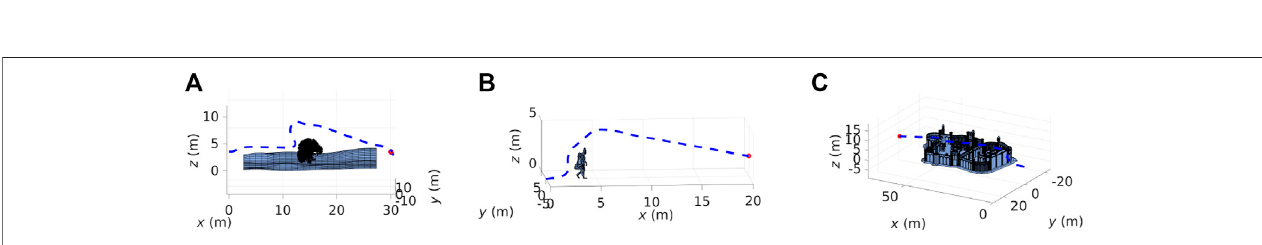
Frontiers in Robotics and AI |